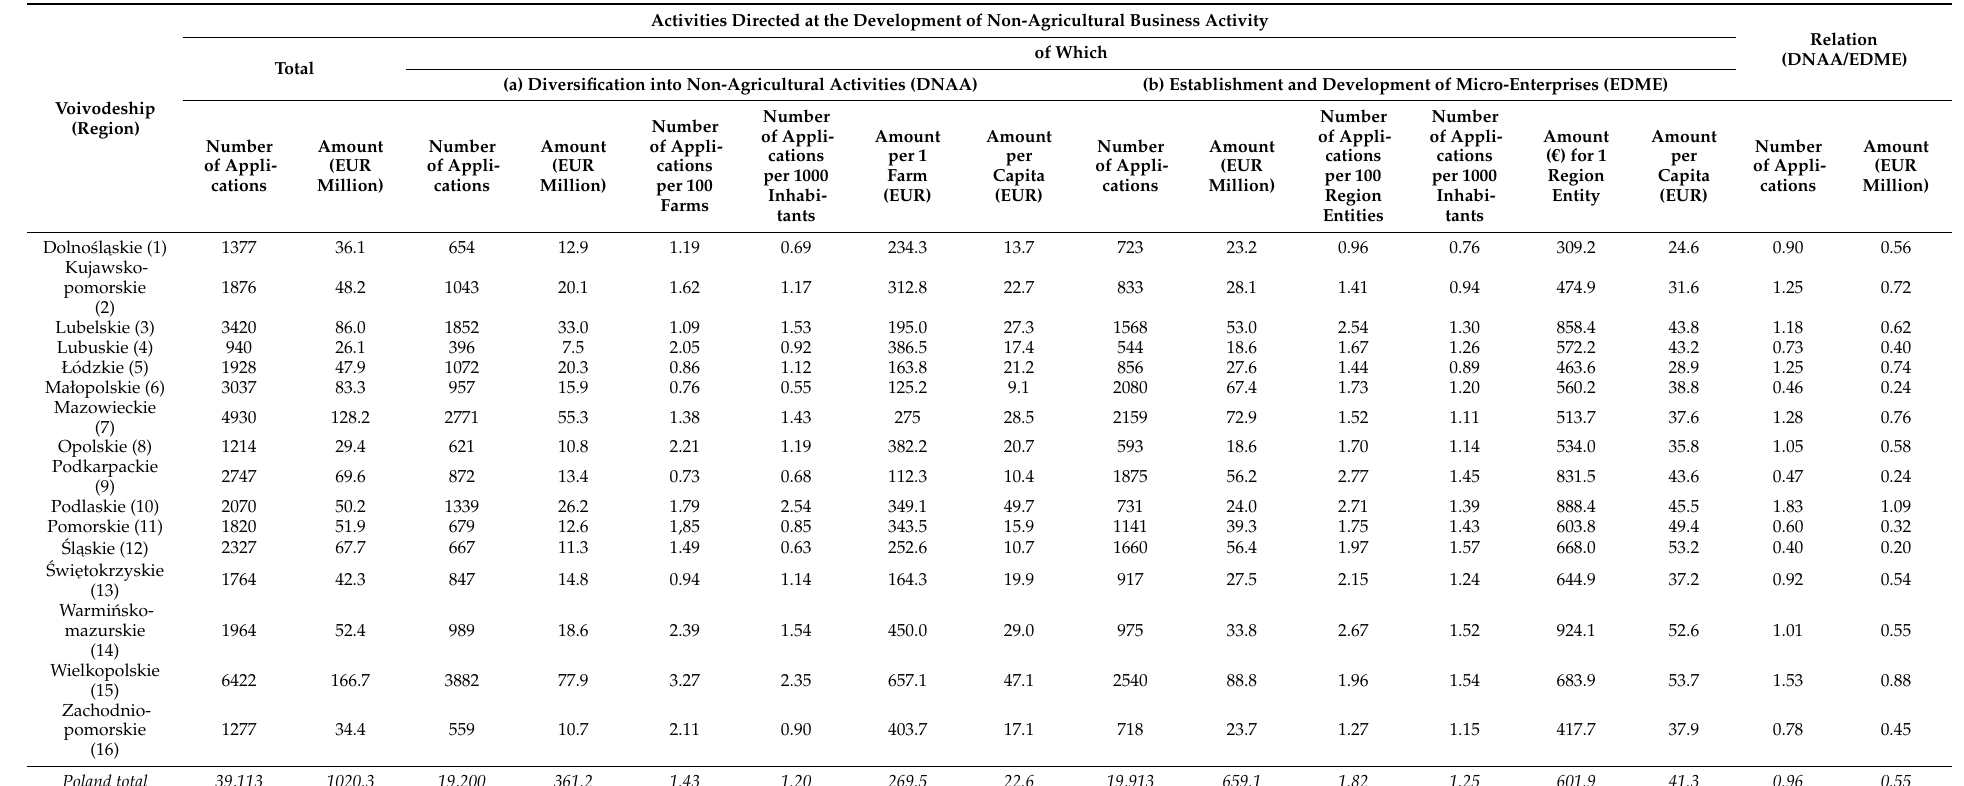
Table A1. Activities directed at the development of non-agricultural business activity